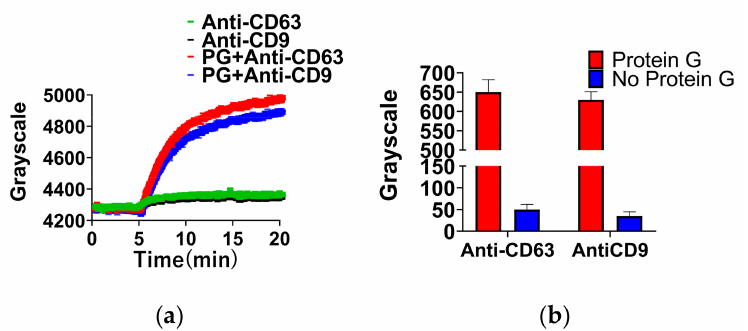
Figure 2. Detection of antibodies with or without protein G by TIRIE. ( a ) The real-time curve of the sensing surface in four cases. ( b ) The sensing signal variation of antibodies on the surface with or without protein